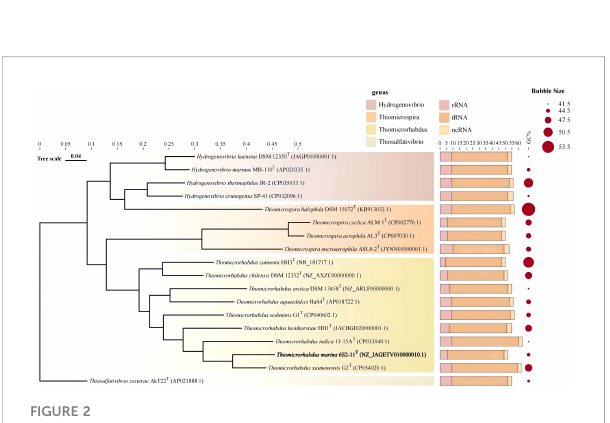
FIGURE 2 Genome phylogenetic tree. Stacked bar charts represent the number of different RNAs. Circle plots indicate GC